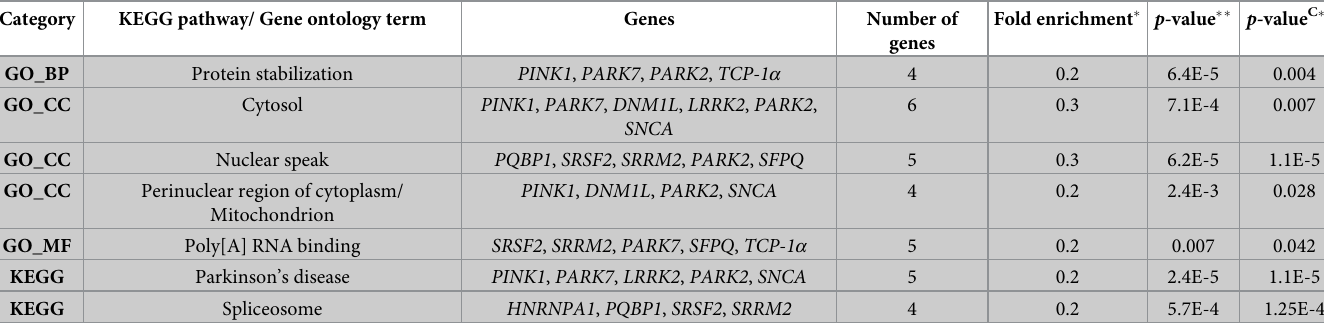
Table 2. Functional enrichment analysis of SRRM2 with 12 associated